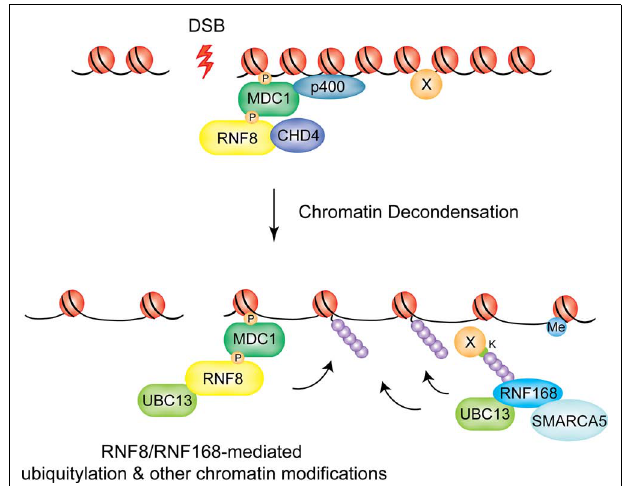
FIGURE 2 | Chromatin decondensation at DSBs. The chromatin remodeling factors p400 and CHD4 mediate large-scale chromatin decondensation at DSB sites, promoting RNF8/RNF168-mediated ubiquitylation and other chromatin modifications. P400 is recruited by MDC1, CHD4 by RNF8. SMARCA5 is recruited through RNF168 and promotes its activity at DSBs.